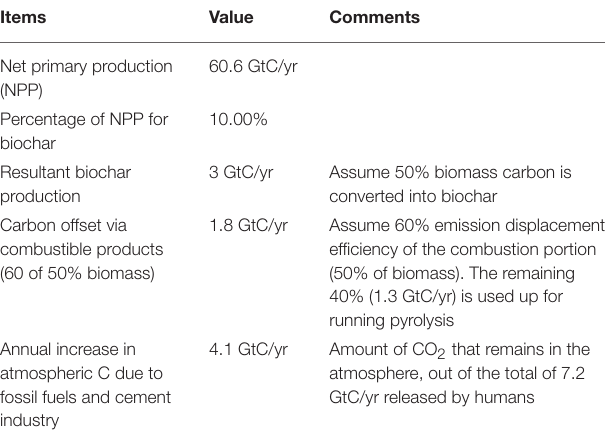
TABLE 9 | Potentials for worldwide carbon sequestration via biochar production and dispersion over agricultural land (Jones and Ogden, 1984).